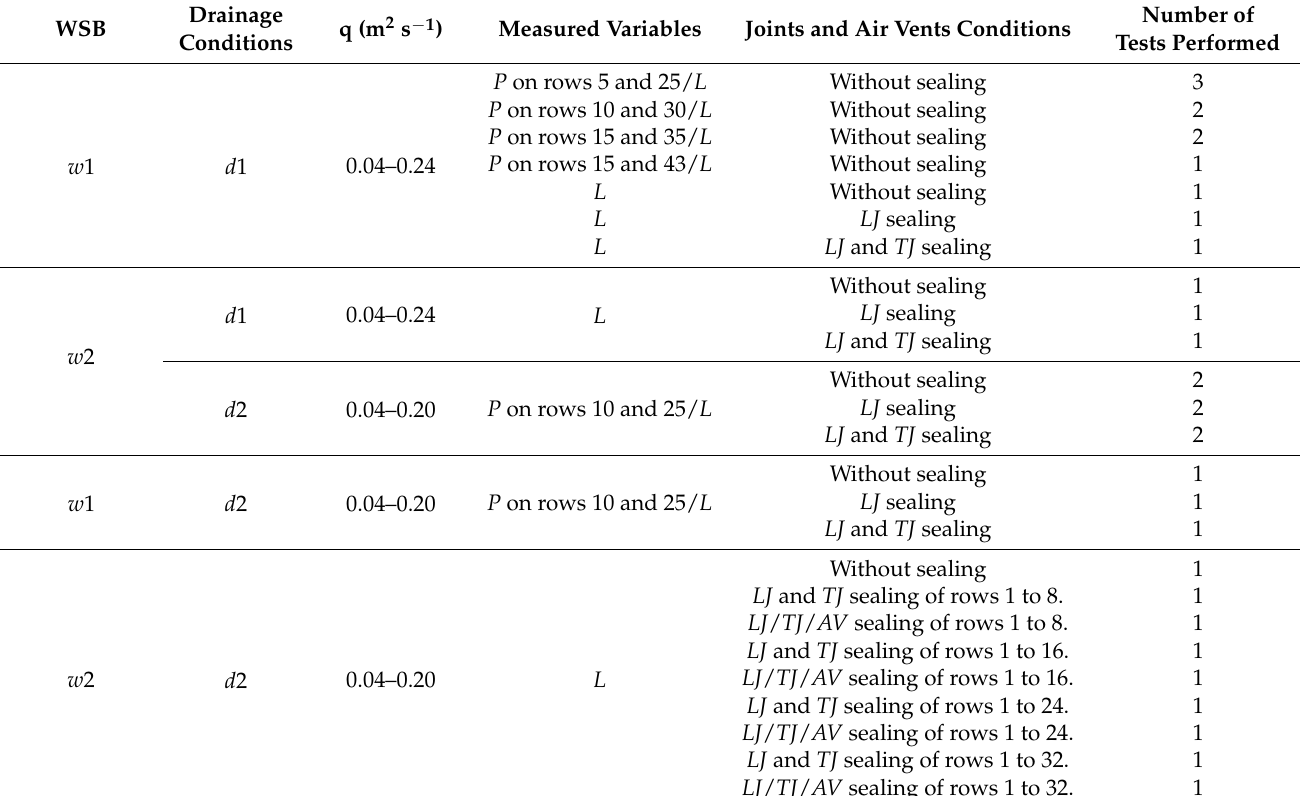
Table 4. A summary of tests carried out (chronologically ordered): Armorwedge TM block ( w 1), ACUÑA block ( w 2), Free drainage conditions ( d 1) and Granular layer drainage conditions ( d 2). Measured variables: P , hydrodynamic pressures